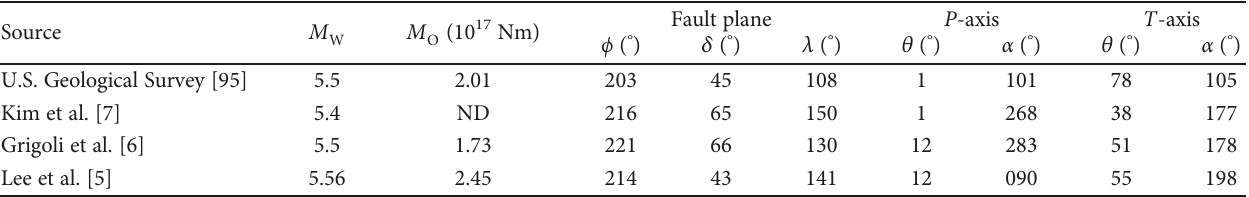
Figure 4: Conceptual block-diagram illustrating the complexity of a major fault, from Figure 1 of [88]. This diagram shows the main components of a fault zone (i.e., the fault core and damage zones) and structural elements and features in each component, for comparison with Figure 3. A transitional (or mixed) zone is depicted at the boundary between the impermeable fault core and permeable damage zones. Fracture development into such a fault zone by hydroshearing might interact with permeable elements, including fractures and secondary faults within the damage zone and shear zones within the transitional zones. Table 2: Earthquake source